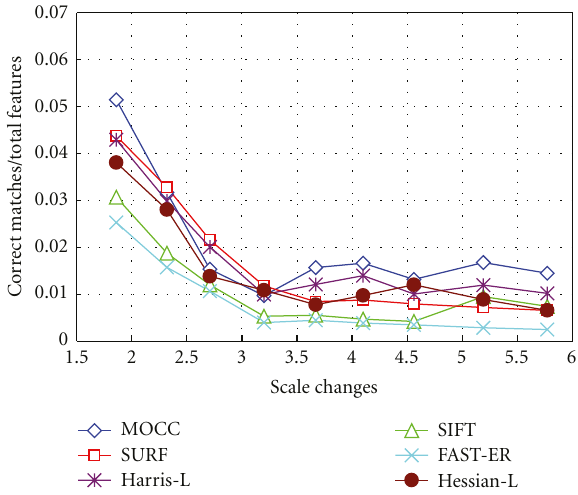
Figure 14: Performance